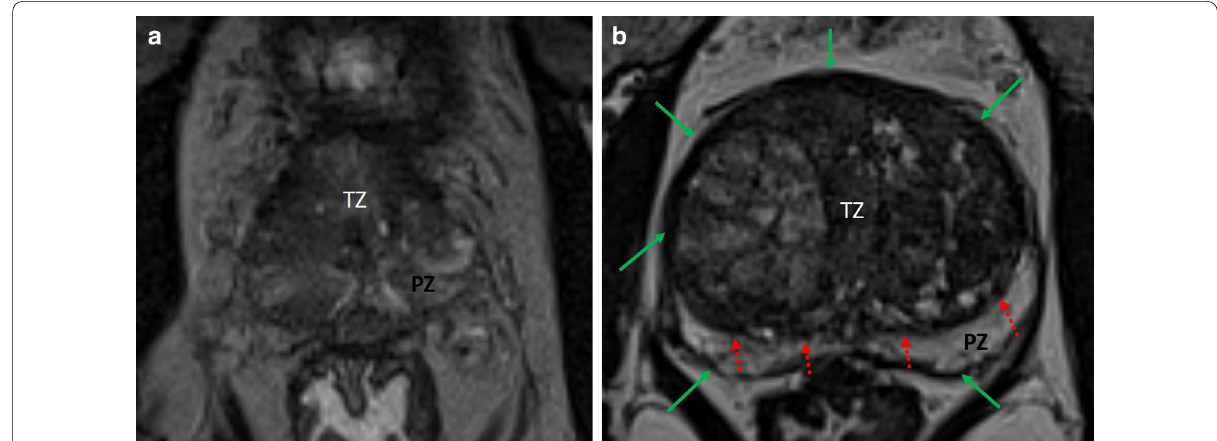
Fig. 4 Influence of variation in prostate volume on zonal differentiation. a Poor zonal differentiation in a small prostate volume (20 cm 3 ); b Clear zonal anatomy differentiation in a larger prostate volume (120 cm 3 ): pseudo‑capsule (green arrows) and TZ delimitation (red dotted arrows) are clearly individualizable